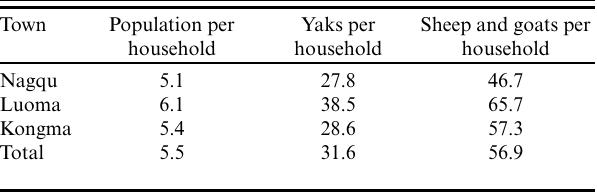
Table 4 . Number of livestock per household in the study